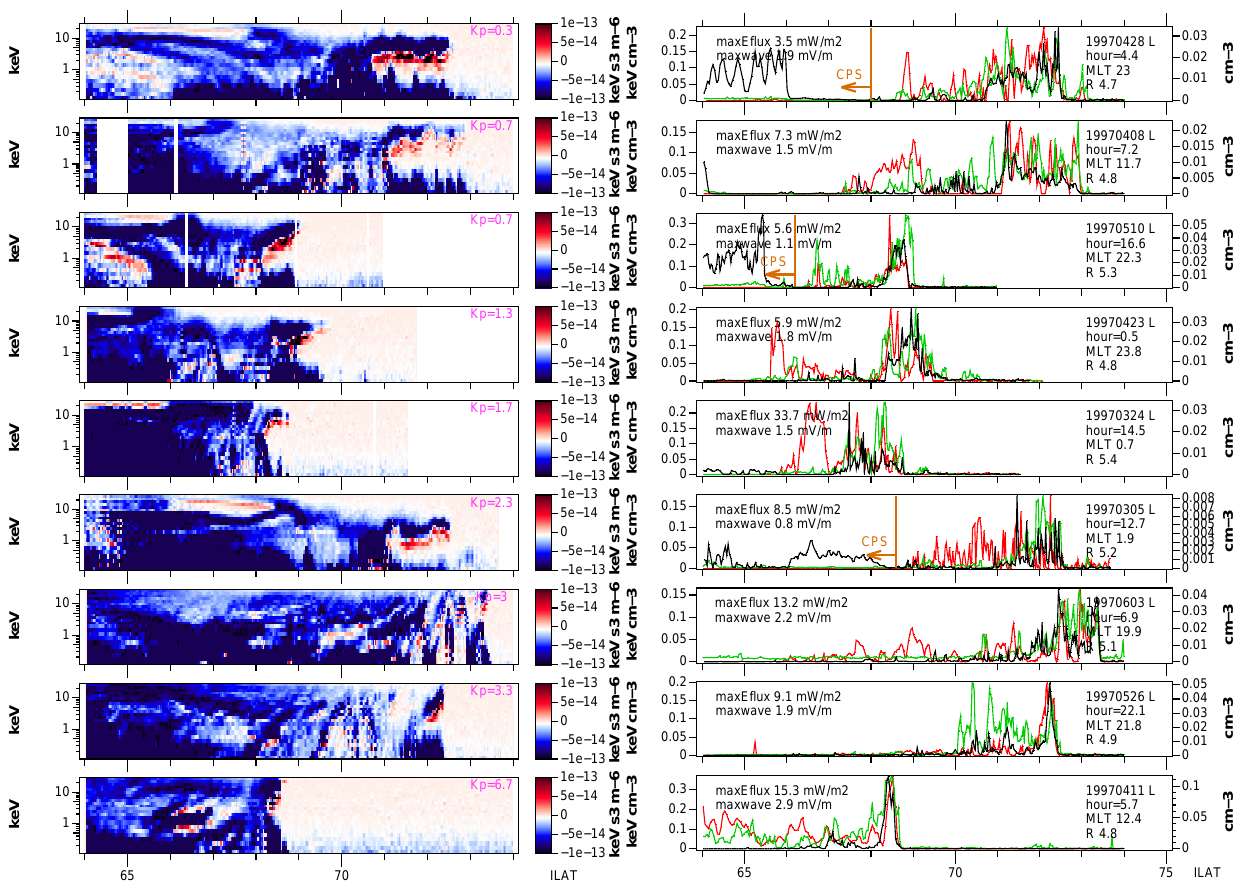
Fig. 5. Each panel is one event, where the Polar/Timas satellite passes through the auroral zone. Black line is free energy from TIMAS (scale on the left) and red line is magnitude of electron anisotropy from HYDRA (scale on the right). Green line is unnormalised perpendicular wave power from EFI (12-s averaged); its attained maximum is written on the left (“maxwave”). Maximum downward ion energy flux from TIMAS during time when free energy exceeds 0.02 keVcm − 3 is also given; the value is given at the ionospheric level by multiplying the measured value by flux tube scaling factor. Event date and average UT-hour, MLT and radial distance are also given. The letter L(R) after the date indicates that satellite is moving to the left (right), i.e. towards decreasing (increasing)